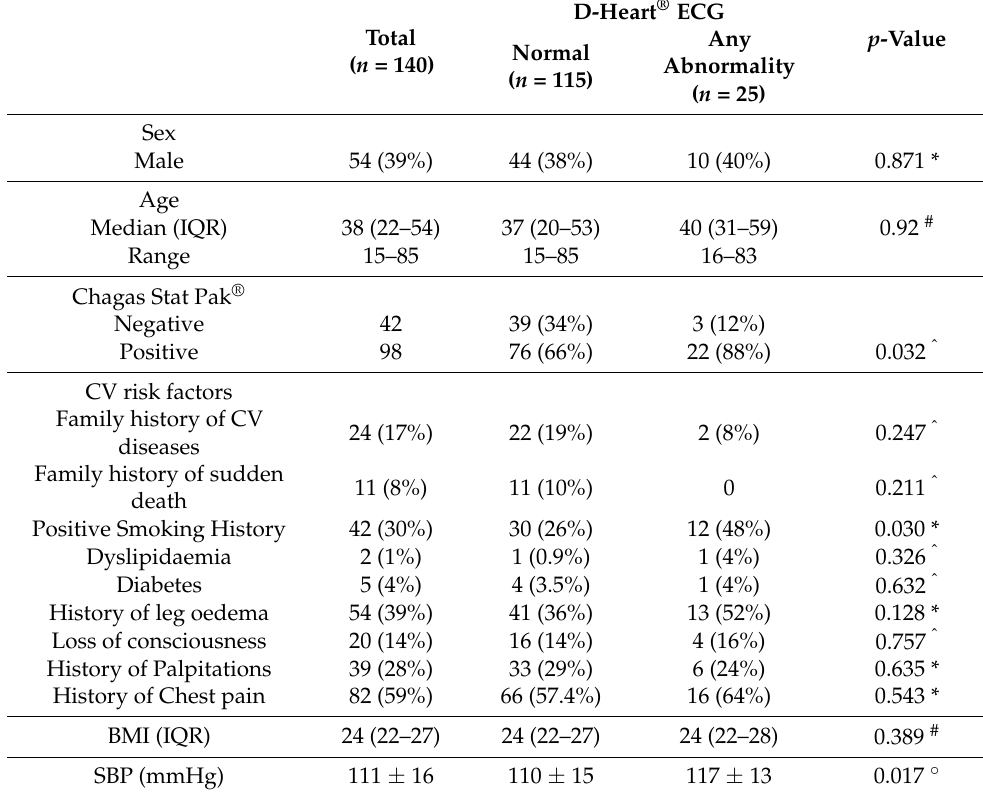
Table 3. Characteristics and cardiovascular risk factors of the surveyed population in a rural commu- nity of the Bolivian Chaco, by D-Heart ®